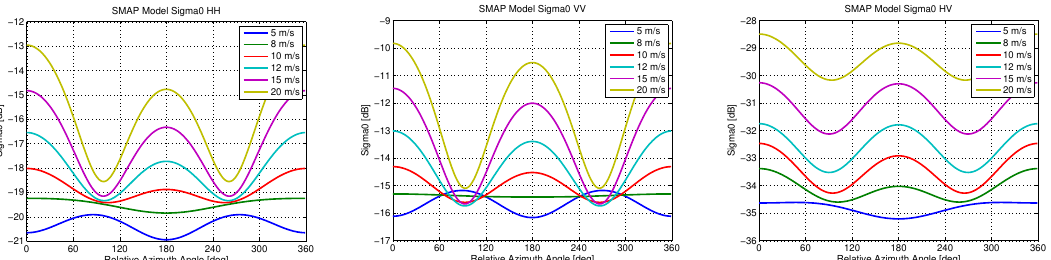
Figure 1. ( left ) Geophysical Model Function in dB for HH polarization, as a function of relative azimuth angle with different wind speeds as different lines, ( middle ) same for VV polarization, ( right ) same for HV polarization. Note the large wind direction modulation for co-polarizations, while the cross-polarization has much less dependance on wind direction. Also note the change in sign of directional modulation and non-monotonicity of the GMF in wind speed as cross-wind. Also note the change in sign of the A2 term of the GMF, which for the VV polarization causes non-monotonic relation between wind speed and σ 0 for particular azimuth